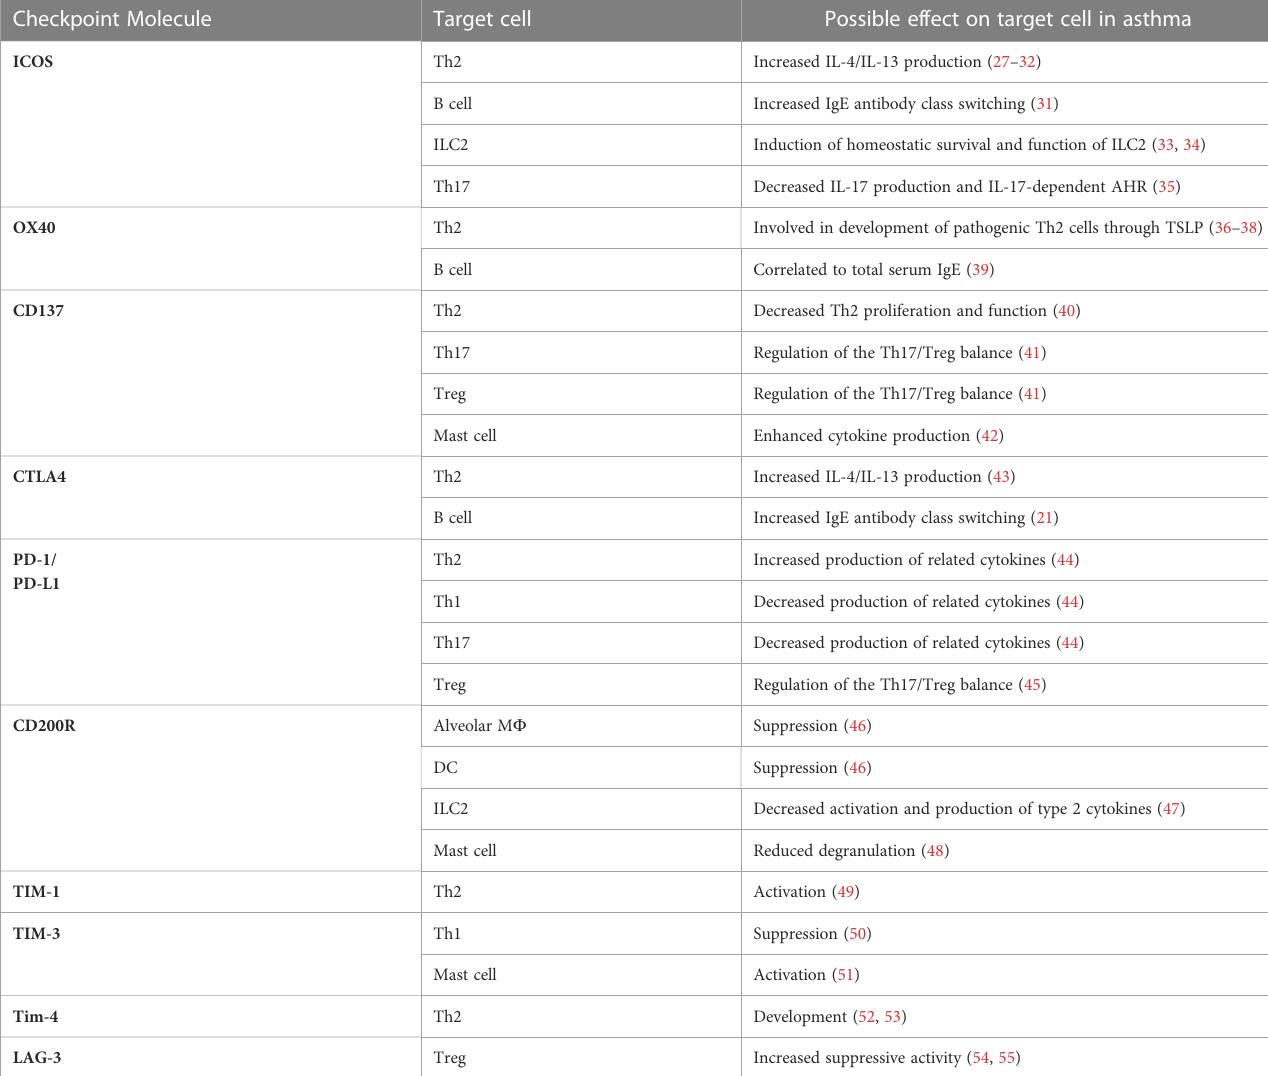
TABLE 1 Effects of co-inhibitory/co-stimulatory immune checkpoints in